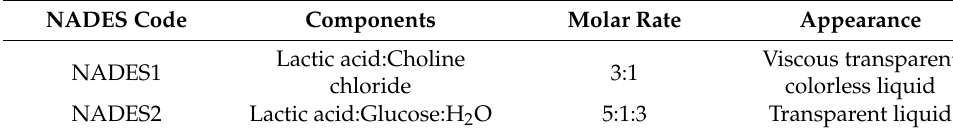
Table 1. Natural deep eutectic solvents (NADES) used for extraction. NADES Code Components Molar Rate Appearance Lactic acid:Choline NADES1 5:1:3 Transparent